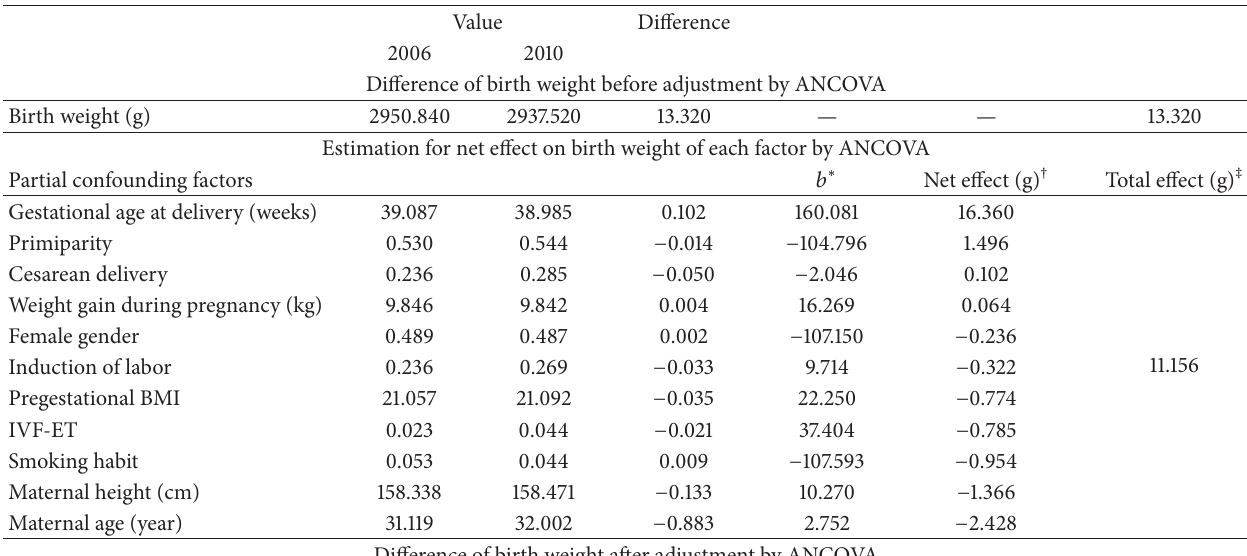
Table 3: Differences of birth weight between 2006 and 2010 before and after adjusting each confounding factor by ANCOVA. Value Difference 2006 2010 Difference of birth weight before adjustment by ANCOVA 2950.840 2937.520 13.320 Estimation for net effect on birth weight of each factor by ANCOVA 𝑏 ∗ Net effect (g)